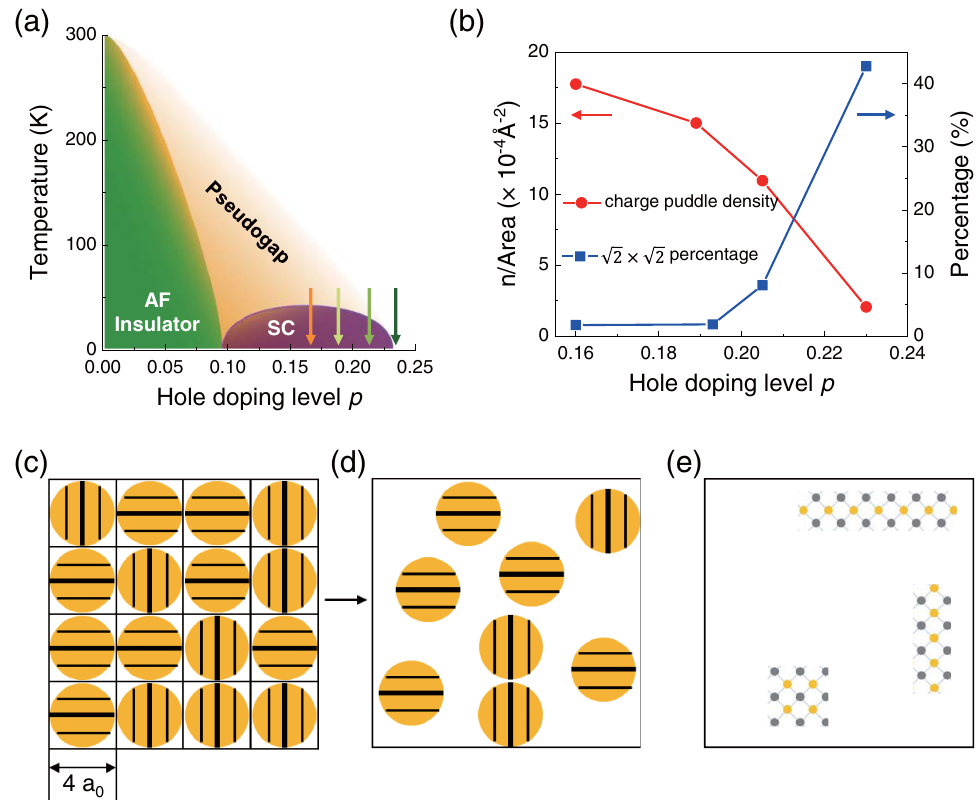
FIG. 5. The doping evolution of charge orders. (a) The schematic electronic phase diagram of Bi-2201, and the arrows indicate the hole densities of the four samples studied in this work. (b) Doping dependence of the charge puddle density and the percentage of ffiffiffi p ffiffiffi p 2 2 areas with × charge order. (c) – (e) Schematic cartoons illustrating the evolution of charge order with increasing doping. The yellow spheres represent the charge puddles with a size of approximately 4 a 0 and the black lines sketch the internal stripy structure. In the overdoped non-SC sample, the charge puddles with stripy internal structure disappear, and small patches with order